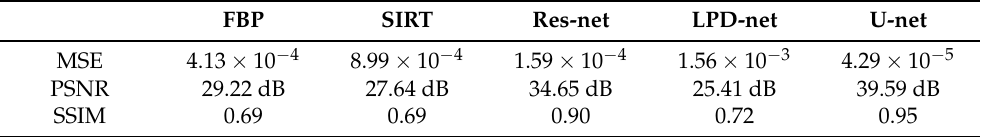
Table 4. Reconstruction metrics comparison of different methods with 60 angles